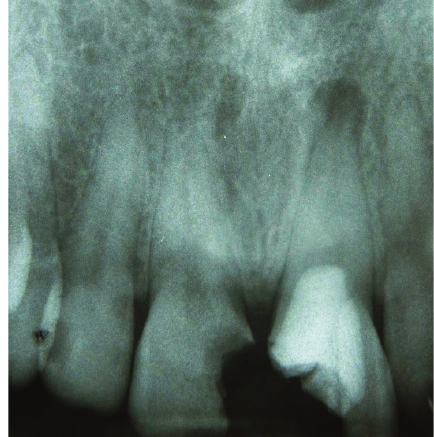
Figure 2: Preoperative radiograph; root canal of the left maxillary central incisor has been over-prepared and periapical radiolucency is observed at the apex of the tooth.